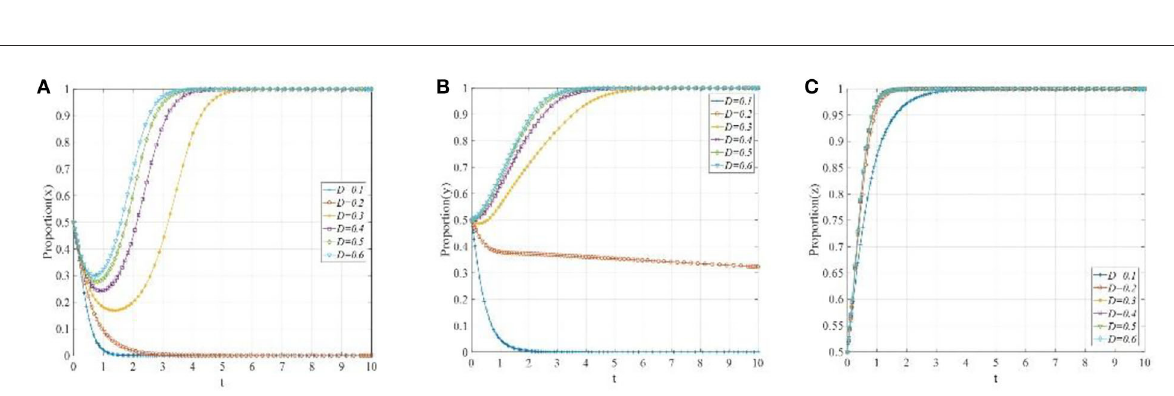
FIGURE13 The sensitivity analysis of the centrality degree of investors when D = 0.1, 0.2, 0.3, 0.4, 0.5, 0.6. (A) The sensitivity of P2P lending platforms; (B) The sensitivity of investors; and (C) The sensitivity of financial regulators.